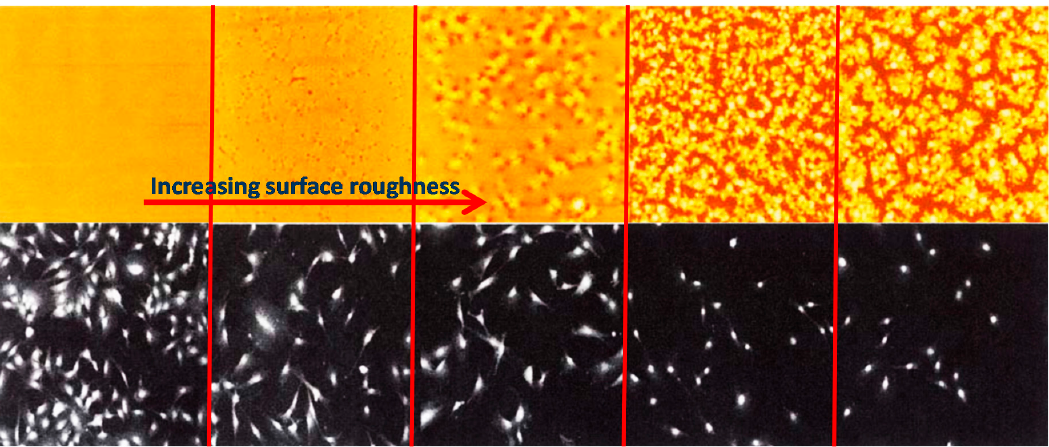
Figure 10. Montage of representative images of PLLA morphology from AFM data (top panels, field of view in each image is 20 μ m), and corresponding cell count from fluorescent microscopy (bottom panels, field of view in each image is 1500 μ m) [61].